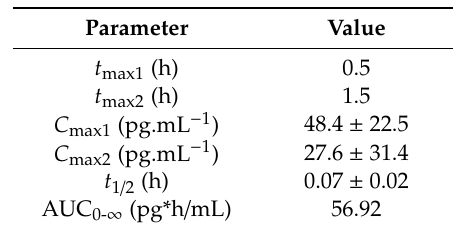
Table 2. Pharmacokinetic parameters after the oral administration of a single dose (0.3 MIU, 1.4 pg, 0.07 pg / kg) of CT-NPs to BalbC mice.